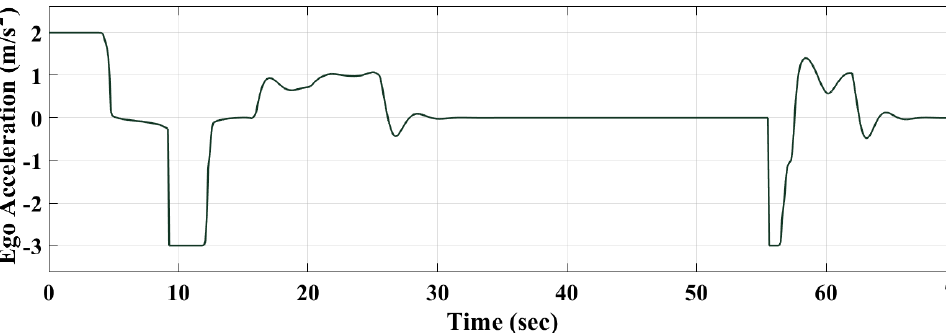
Figure 16. Velocity of ego and proceeding vehicle compared to reference velocity—MPC controller.